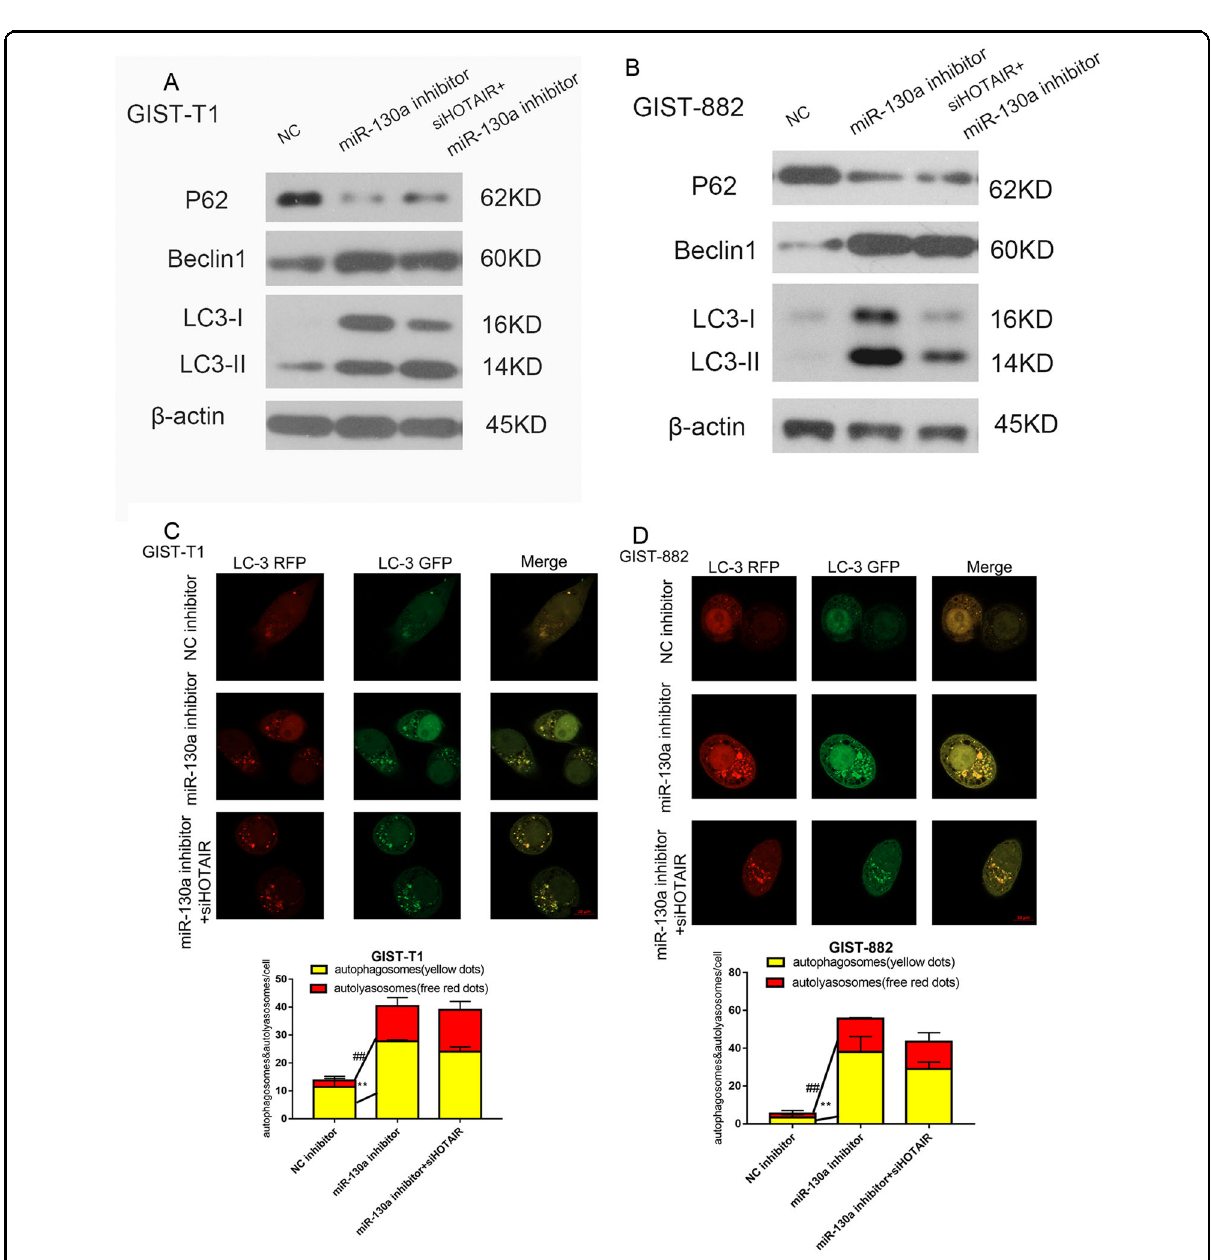
Fig. 4 HOTAIR regulates cell autophagy via miR-130a. A , B The levels of autophagy-related proteins (Beclin1, p62, LC3) were detected using western blotting. C , D Confocal microscopy images: red dots indicate autolysosomes. ## P < 0.01 vs. the NC inhibitor; yellow dots indicate autophagosomes. ** P < 0.01 vs. the NC